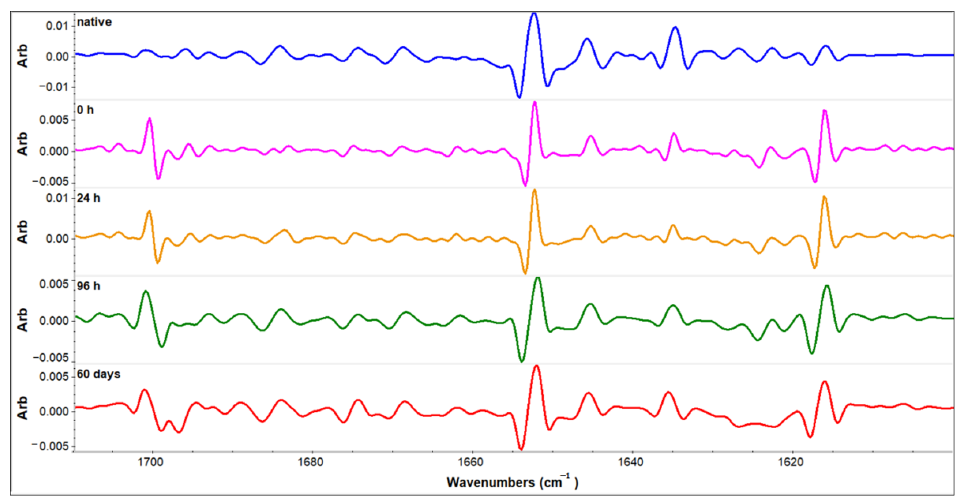
Figure 6. Second derivative spectra of native HEWL sample in H 2 O solution and HEWL samples Figure 6 incubated in 90% C 2 H 5 OH for the time period